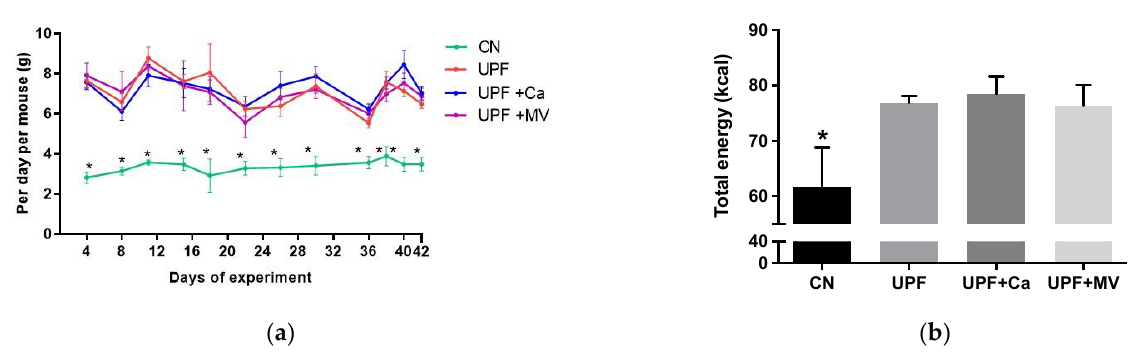
Figure A2. ( a ) Food intake throughout the experiment ( b ) Total energy intake during experiment. * stands for significant differentiation of the CN from the other groups. CN – control, UPF – ultra processed food, UPF+Ca - ultra processed food supplemented with calcium, UPF+MV - ultra processed food supplemented with multivitamin and mineral complex. Table A1. Serum biochemistry analysis at the two end points of the experiment; different letters stand for significantly different results within the single timeline ( p < 0.05). CN – control, UPF – ultra processed food, UPF+Ca - ultra processed food supplemented with calcium, UPF+MV - ultra processed food supplemented with multivitamin and mineral complex. ALP-alkaline phosphatase, SGOT-serum glutamic-oxaloacetic transaminase, SGPT-serum glutamic-pyruvic transaminase, CPK-creatine phosphokinase.